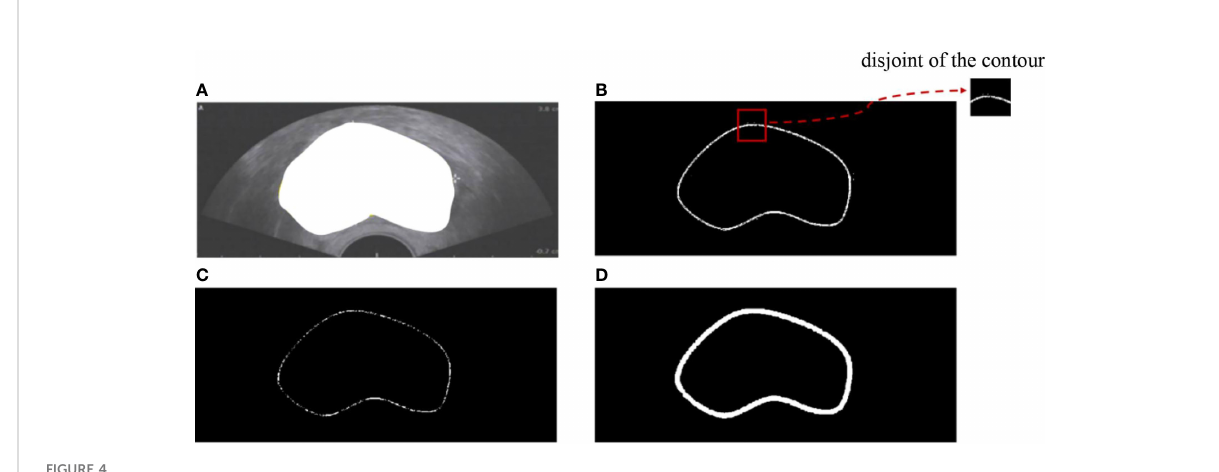
FIGURE 4 Illustration of coarse boundary